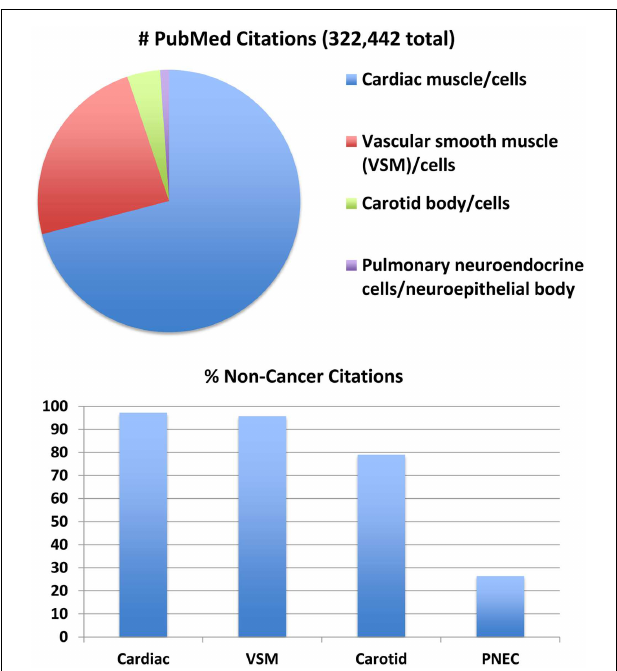
FIGURE 1 | Major subsets of O 2 -sensing cells: proportions of the total number of 322,442 publications per subgroup .Top panel: relative numbers of citations per subgroup in July 2014.This comparison addresses four major subgroups of O 2 -sensing cells: cardiac muscle/cardiomyocytes, vascular smooth muscle (VSM)/myocytes, carotid body/glomus cells, and pulmonary neuroendocrine cells (PNECs)/neuroepithelial bodies. Actual numbers are given in the text. Lower panel: when citations including the keyword “cancer” are excluded, the number of citations is decreased per subset by 3–21% for cardiac muscle, vascular smooth muscle, and carotid body, but is decreased 74% for PNECs. (Mary E. Sunday, original unpublished